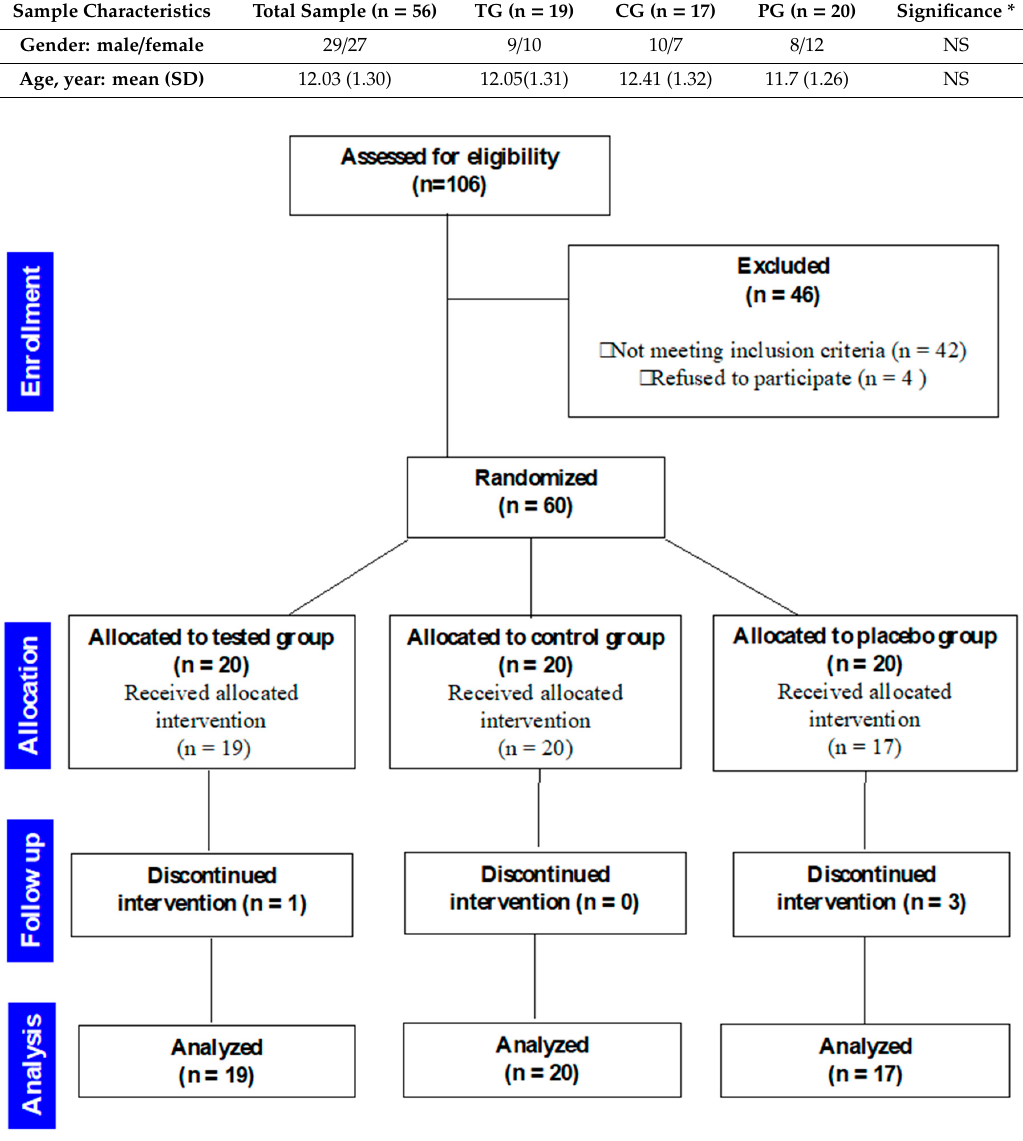
Figure 2. CONSORT